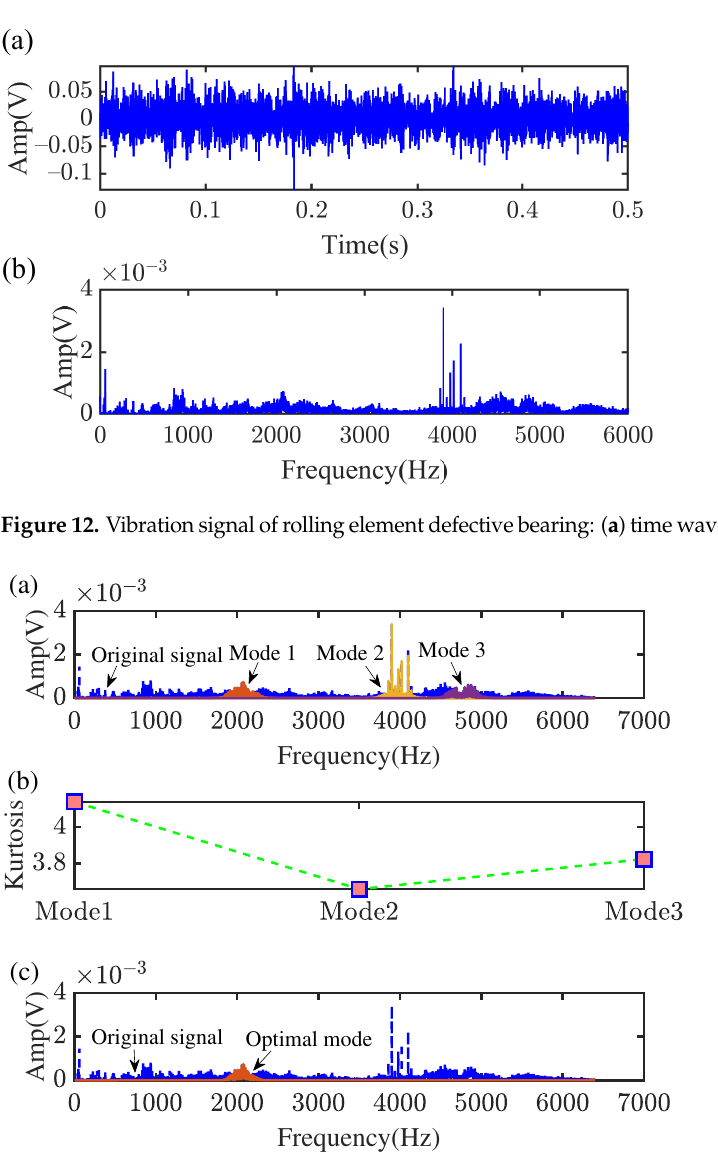
Figure 13. Extraction result by the proposed method: ( a ) extracted modes; ( b ) the kurtosis of different modes; ( c ) the optimal target